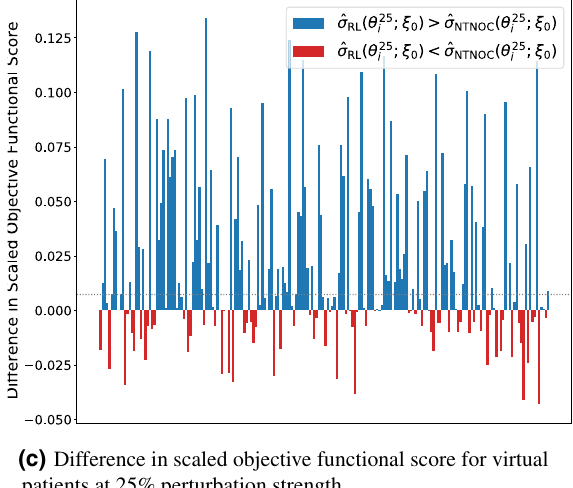
(c) Difference in scaled objective functional score for virtual patients at 25% perturbation strength. Figure 9. Bar plots of the difference between the scores obtained by the reinforcement learner derived policy and the scores obtained by the nearest training neighbour optimal controller on all test virtual patients (i.e. bar plots of ˆ σ RL (θ k i ; ξ 0 ) − ˆ σ NTNOC (θ k i ; ζ k ) ). Testing patients where the reinforcement learner outperformed the optimal controller are marked in blue and patients where the optimal controller outperformed the reinforcement learner are marked in red. The dotted grey lines in each plot indicate difference in the median values of the scores obtained by the reinforcement learning agent and those obtained by the nearest training neighbour optimal